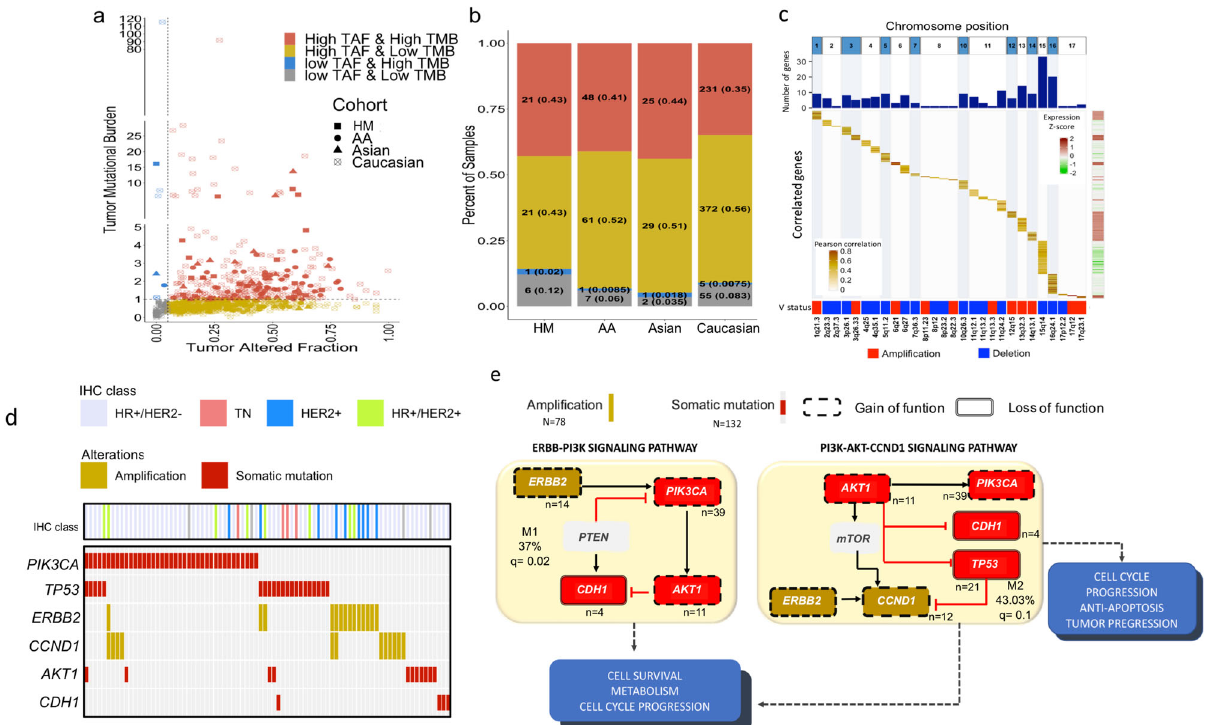
Fig. 7 Integrative view of genomic and transcriptomic alteration in breast tumors carcinogenesis across ancestry groups. a Correlation between tumor mutational burden (TMB) and tumor altered fraction (TAF) divided in four subclasses in accordance with the following cutoffs: high TMB > 1 and high TAF > 5%: High-TMB and Low-TAF, Low-TMB and High-TAF, High-TMB and High-TAF, Low-TMB and Low-TAF. b Prevalence of each biological group divided by TMB and TAF classes (above mentioned) among ancestry groups. c Cis effects of copy-number alterations on mRNA expression in HM. The heatmap shows signi fi cant correlated genes (Pearson R = 0.5, BH-adjusted p -value < 0.05) between SCNA and robust gene expression changes (gene expression pro fi les between altered and non-altered tumors, logFC:1.5, BH-adjusted p -value < 0.05) as illustrated in the sided heat map (over-expression: red, down- expression: green). The diagonal yellow line represents over-expressed genes located in ampli fi ed regions or down-regulated ones located in deleted loci. Genes are ordered by chromosome locations on x -axes. The lower heatmap shows the ampli fi cations (red) and deletions (blue) events in each chromosome. d Altered signaling pathways in breast cancer tumors. Mutual exclusivity modules (MEMo) analysis identi fi ed multiple modules recapitulating ERBB-PI3K , PIK3-Akt-CCND1 signaling (adjusted p -value = <0.1). Heatmap showing the distribution of mutated or ampli fi ed genes that make up MEmo modules. e Graphical representation of the top-scoring mutually exclusive modules. Nodes represents frequently altered genes in each module and edges connect them according to their reported activity in corresponding core signaling pathways. Ampli fi cations are shown in yellow, somatic mutations events in red, black arrows represents activation and red arrows inhibition. Gain of function biological consequence in dot lines and loss of function in continuous line. MEMo p -values were estimated by comparing the observed alteration frequency of each module to those expected for the same module after randomly permuting the set of observed genomic alterations. q: FDR adjusted p -value. HM: Hispanic-Mexican, AA: African-American, IHC: ( HER2 ) ampli fi cation tend to exclude PIK3CA/AKT1 mutations (Fig. 7e). Of relevance, HER2 ampli fi cation is highly correlated with its expression ( R = 90%, adj p -value < 0.05, Fig. 7c) and might be able to activate PI3K/AKT signaling in a HER3 over the same pathway leads to a disadvantage for the cell.